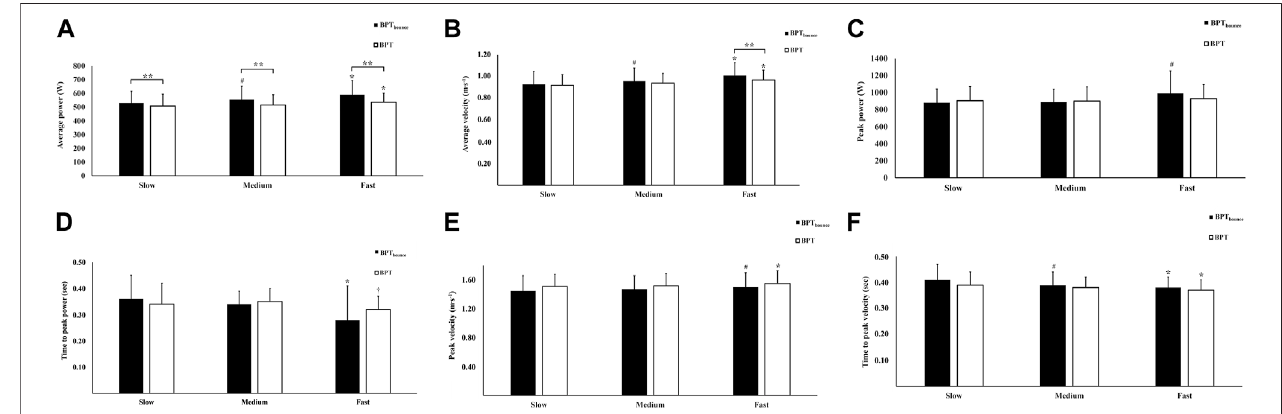
FIGURE 2 | Effect of verbal cueing on bench press performance variables for the BPT bounce technique and BPT on average power (A) , average velocity (B) , peak power (C) , time to peak power (D) , peak velocity (E) , and time to peak velocity (F) . p Signi fi cant difference compared to the other lowering cues. #Signi fi cant difference compared to “ slow ” lowering cue. † Signi fi cant difference compared to “ medium ” lowering cue. pp Signi fi cant difference compared to BPT bounce.